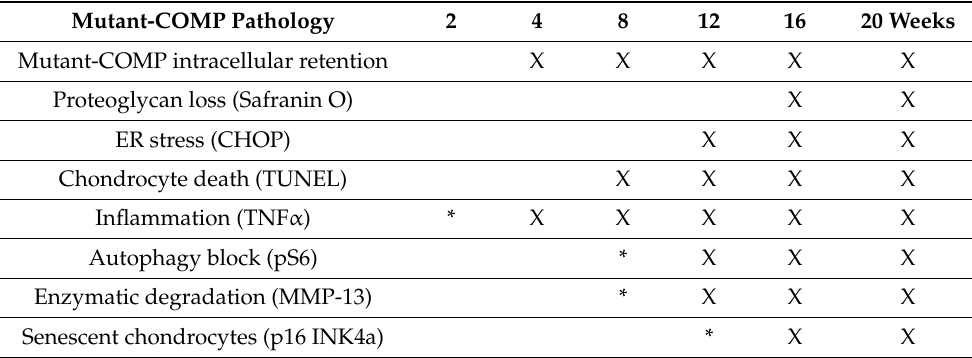
Table 2. Timing of articular chondrocyte